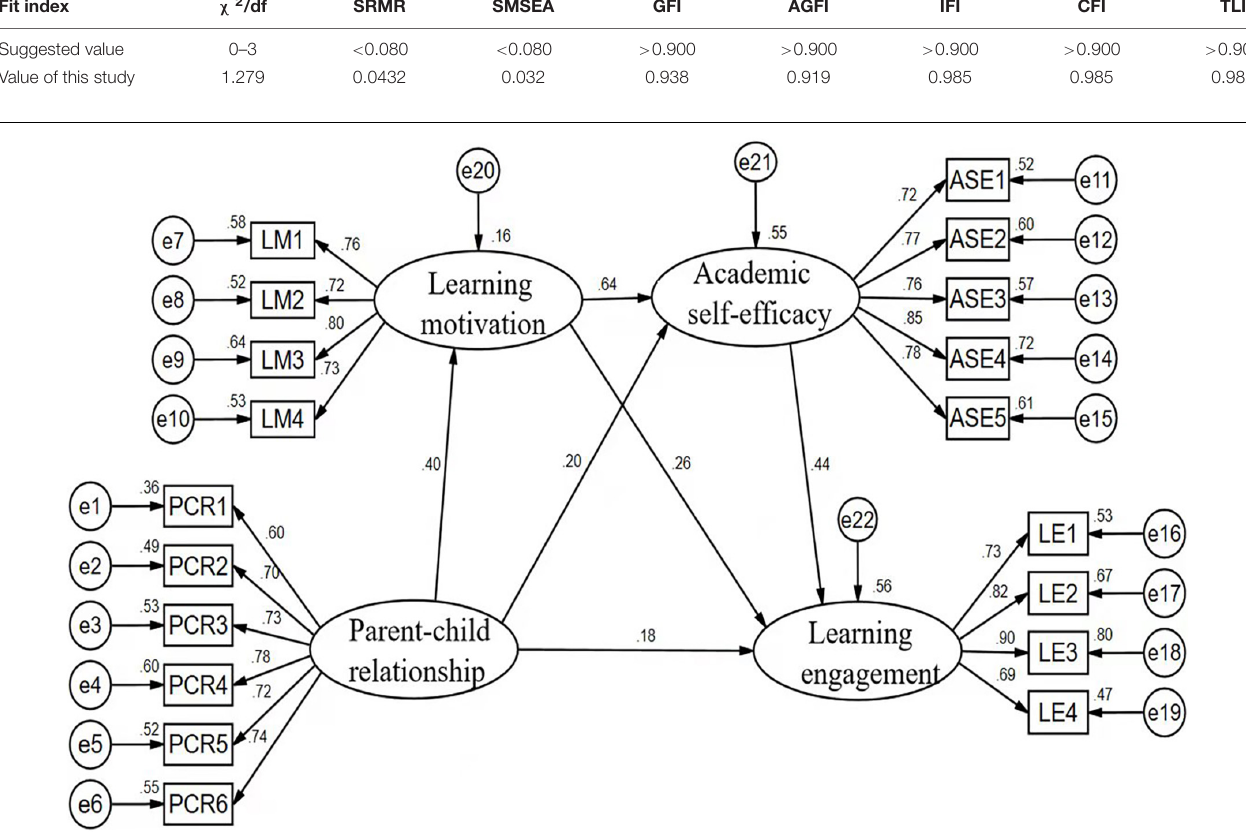
FIGURE 2 | The structural modeling